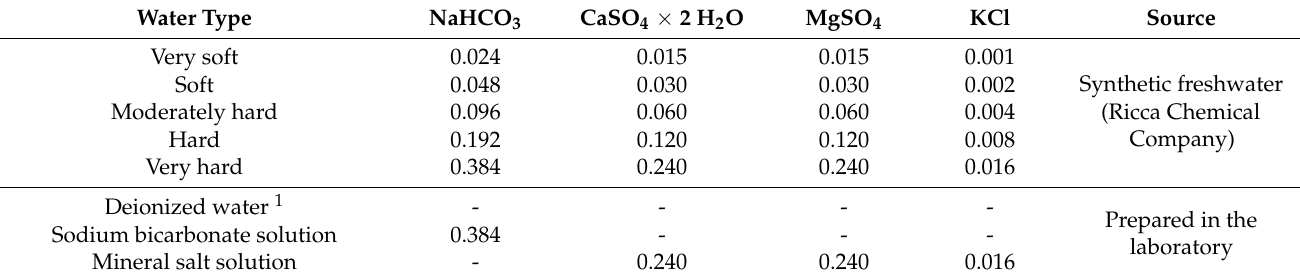
Table 4. Chemical composition of water types used in this study; all concentrations in